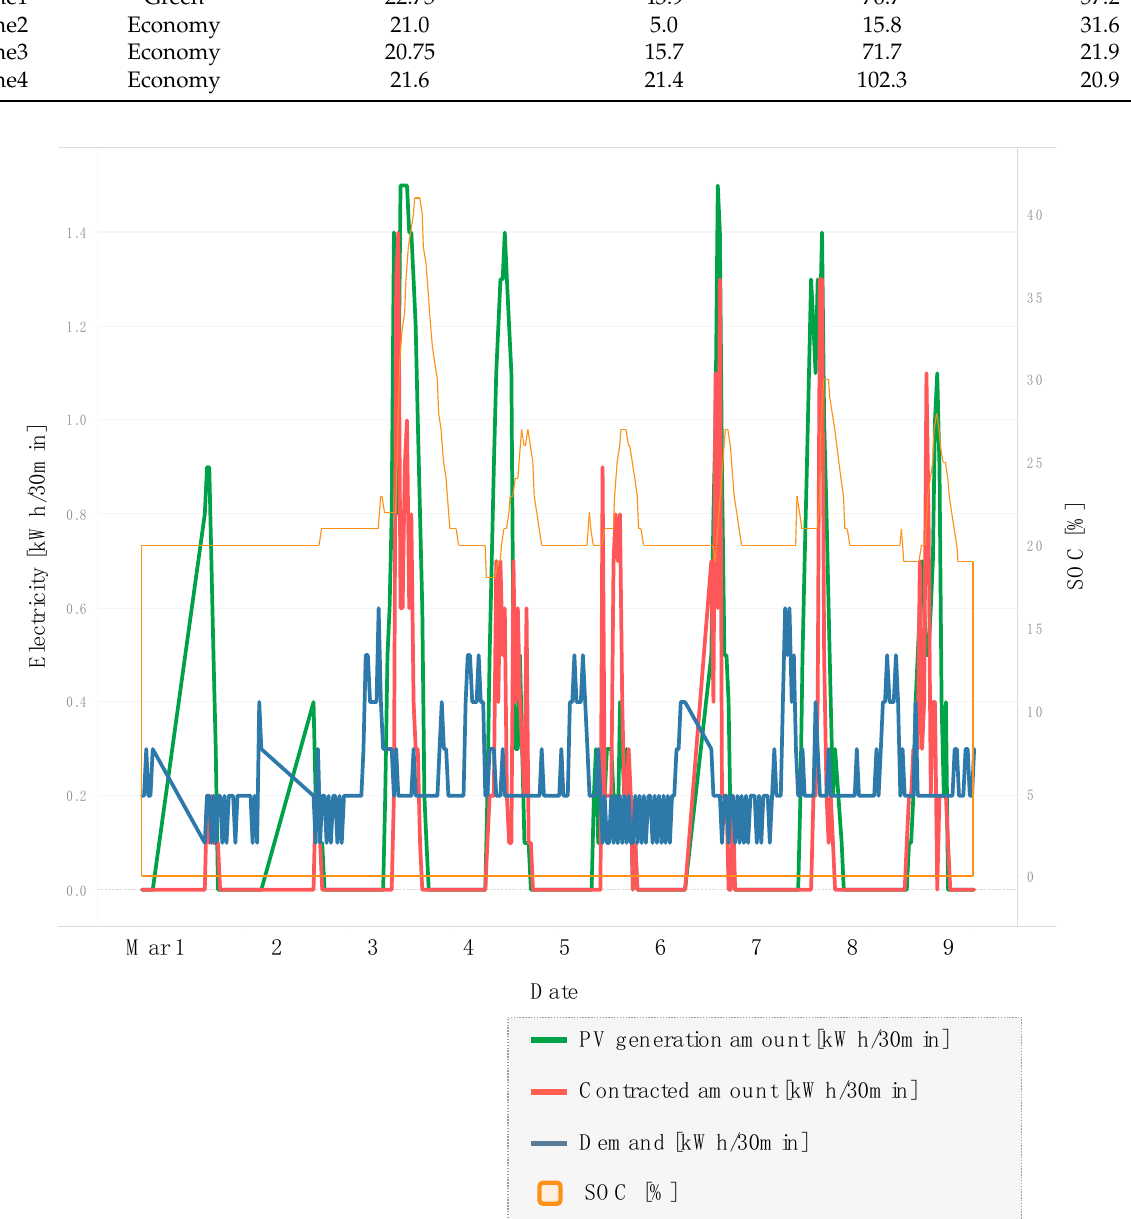
Figure 7. Changes in the status of users who own EVs in the second week.